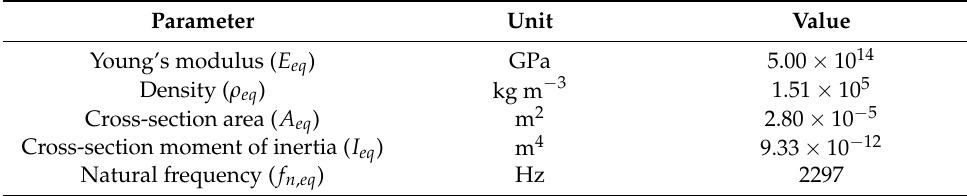
Table 5. Mechanical properties of the equivalent cantilever beam.